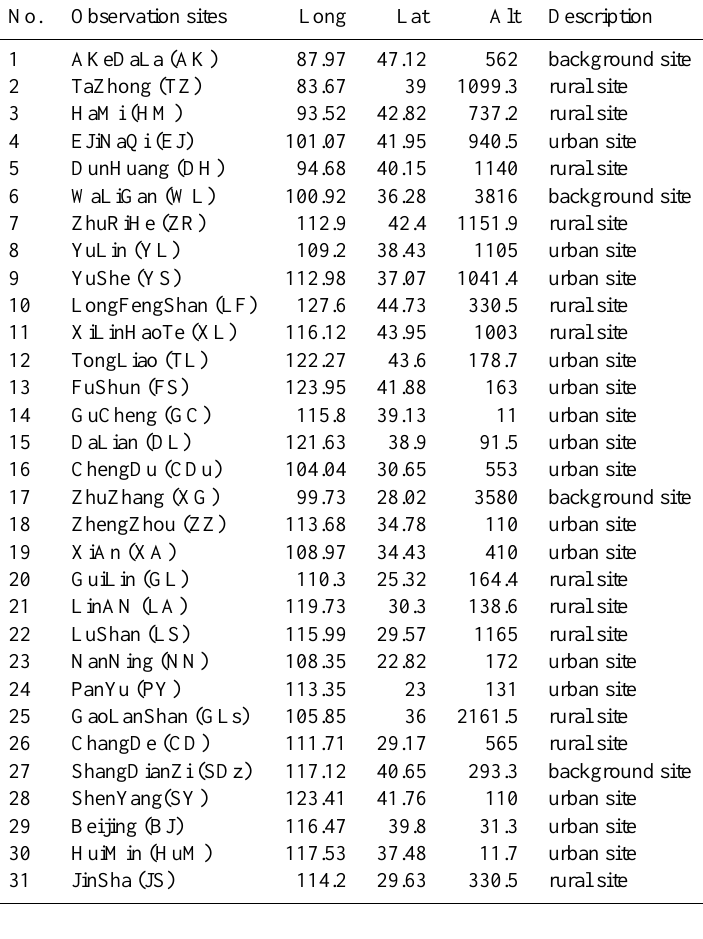
Table 1. Observation site information.